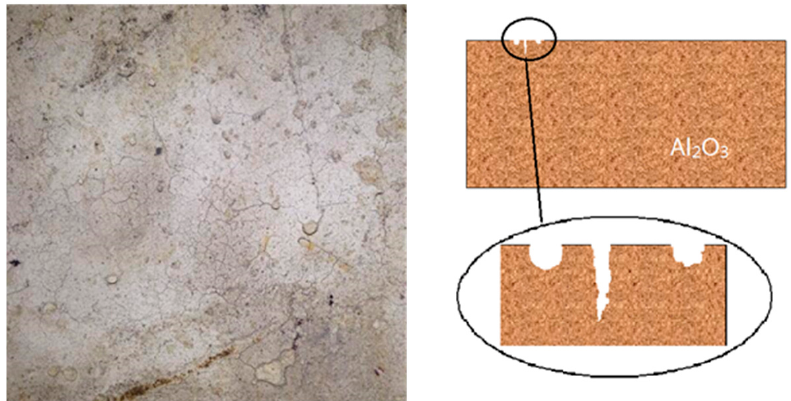
Figure 5. The morphology of crack on refractory brick surface.